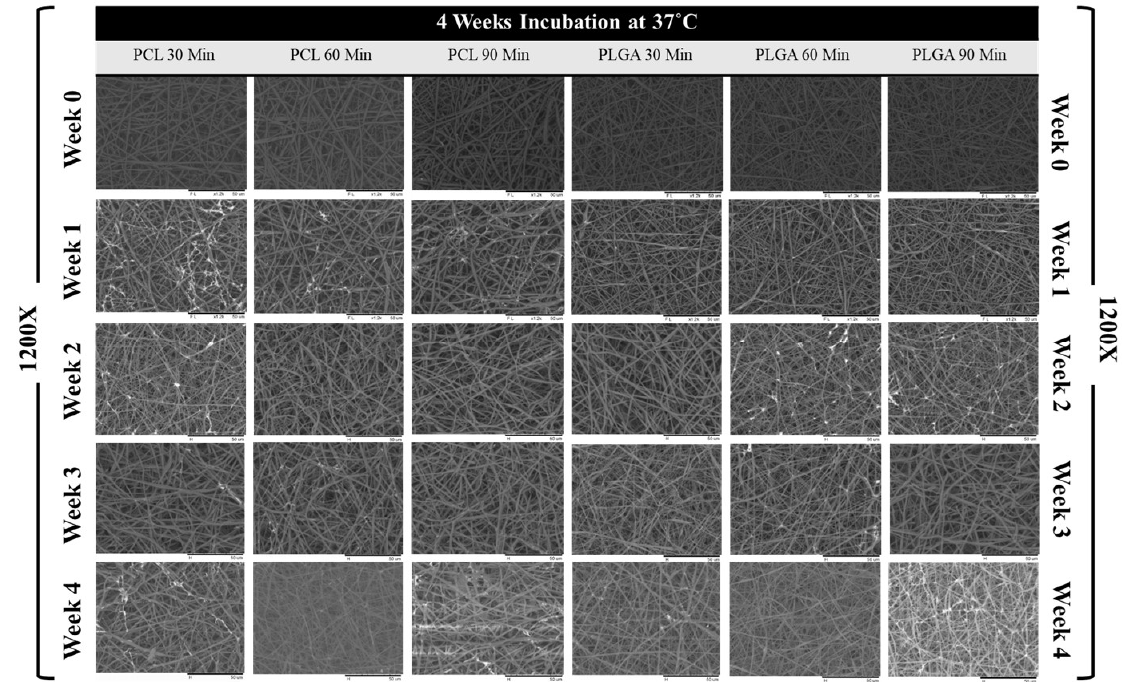
Figure 5. SEM images of electrospun PCL and PLGA scaffolds from weeks 0, 1, 2, 3 and 4 (the degradation period) at 1200× magnification; scale bar: 50 µm.